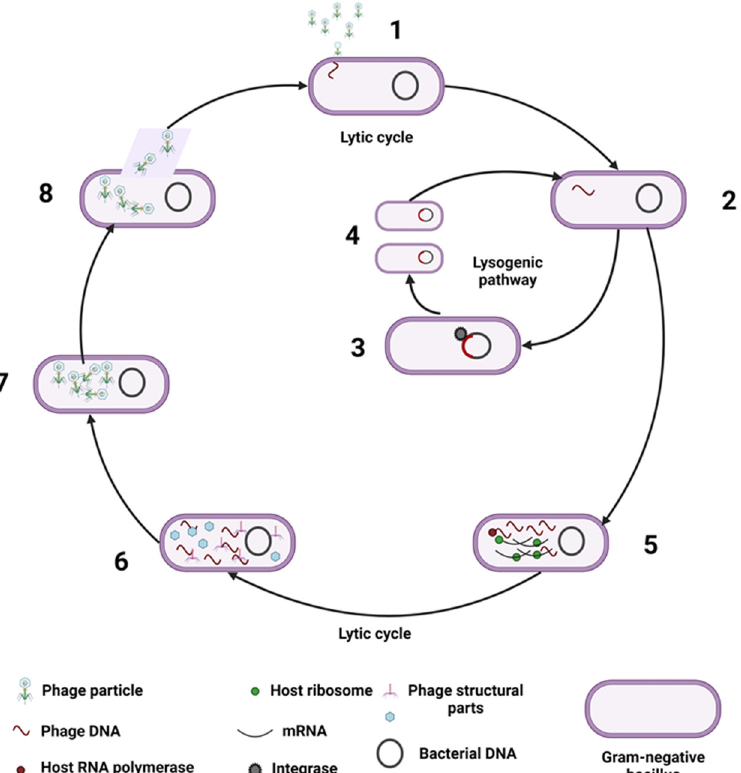
Figure 1. Representation of the main phage infection cycles. (1) Phage interaction with the bacterial